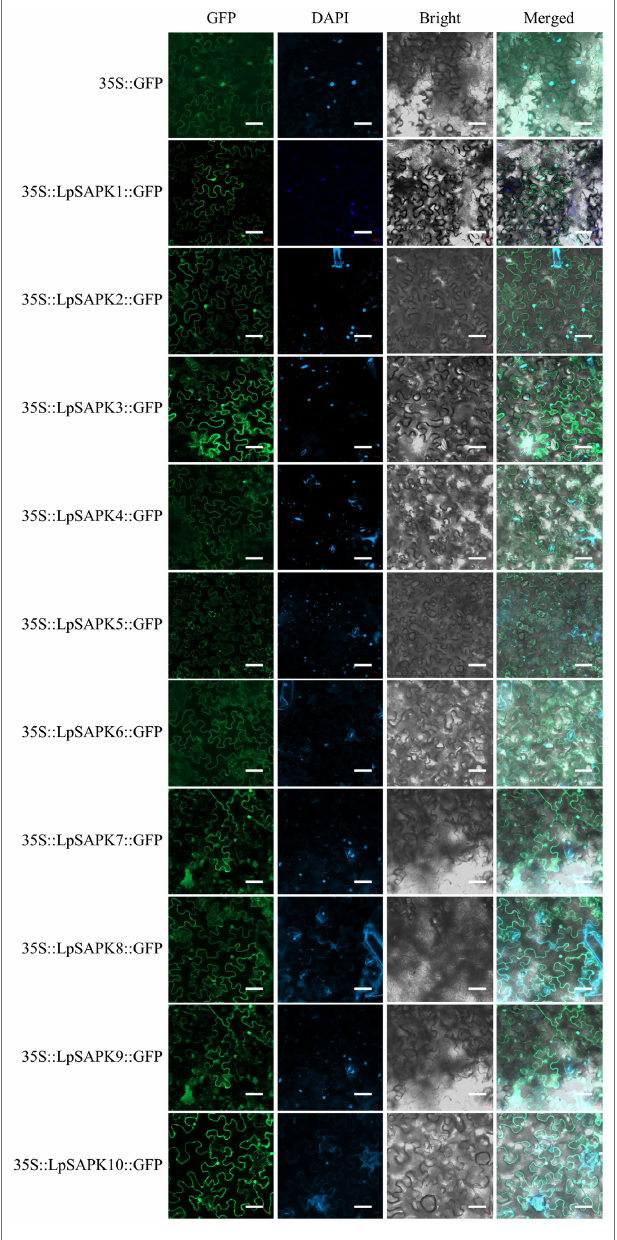
FIGURE 4 | Subcellular localization of the LpSAPK proteins. The vector 35S :: GFP was used as the control. All LpSAPKs were infusion with a GFP tag and visualized as green fluorescence in leaf cells of Nicotiana benthamiana